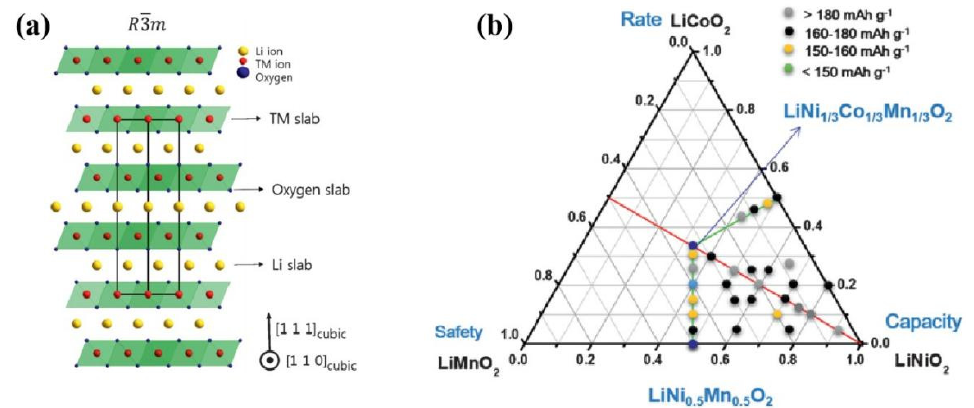
Figure 1. Illustration of the ordered layer structure and phase diagram of NCM materials: ( a ) the hexagonal crystal system layered structure; ( b ) NCM composition phase diagram of several typical Ni-Co-Mn ratios, reproduced from Ref [15], Copyright 2008, The Royal Society of Chemistry.